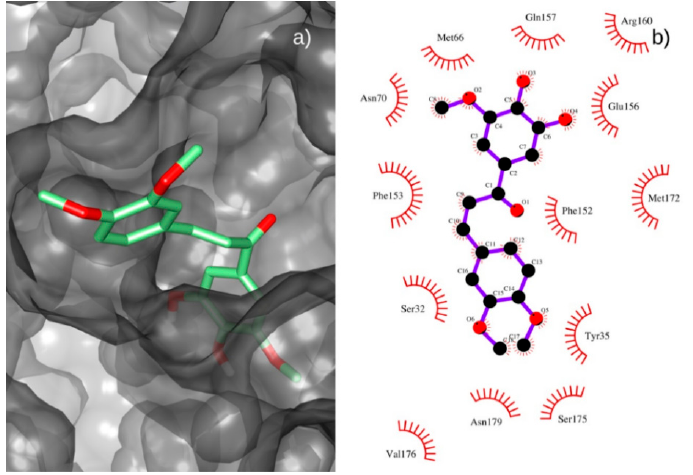
Figure 4. ( a ) Best pose of chalcone 4 (green) on the binding site of the MepA model. ( b ) 2D ligand-protein interaction diagram of chalcone 4 and the MepA protein